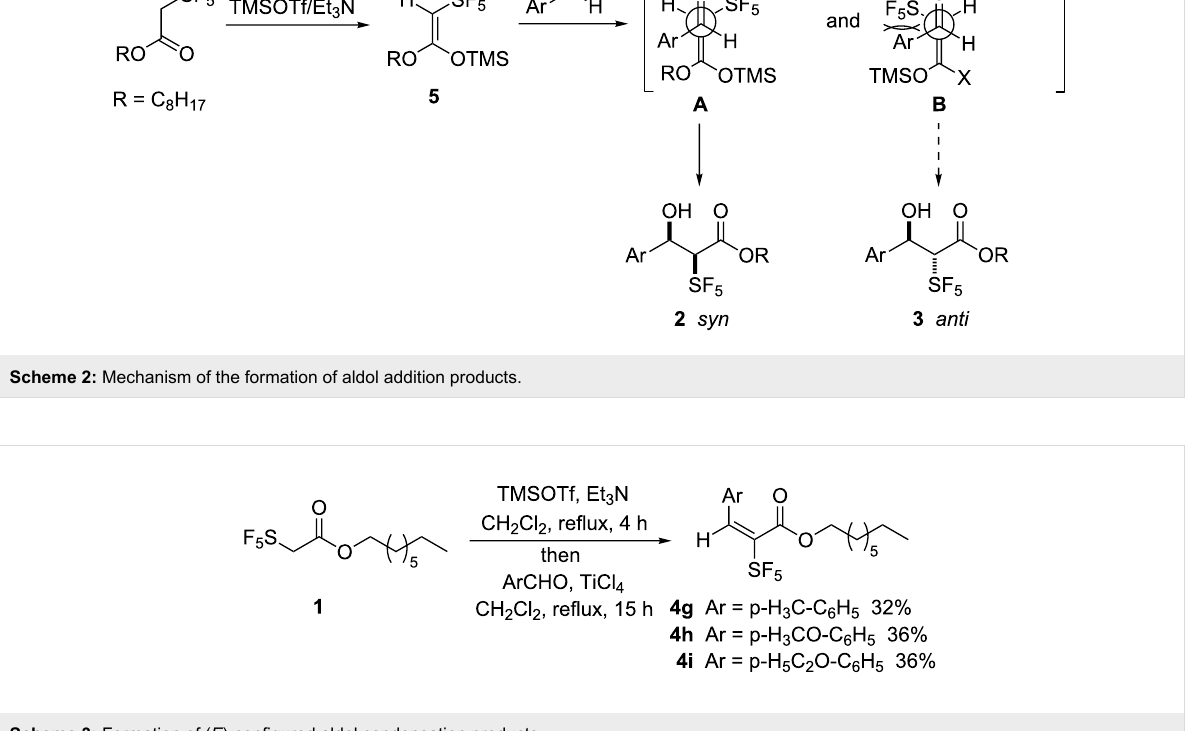
Scheme 3: Formation of ( E )-configured aldol condensation